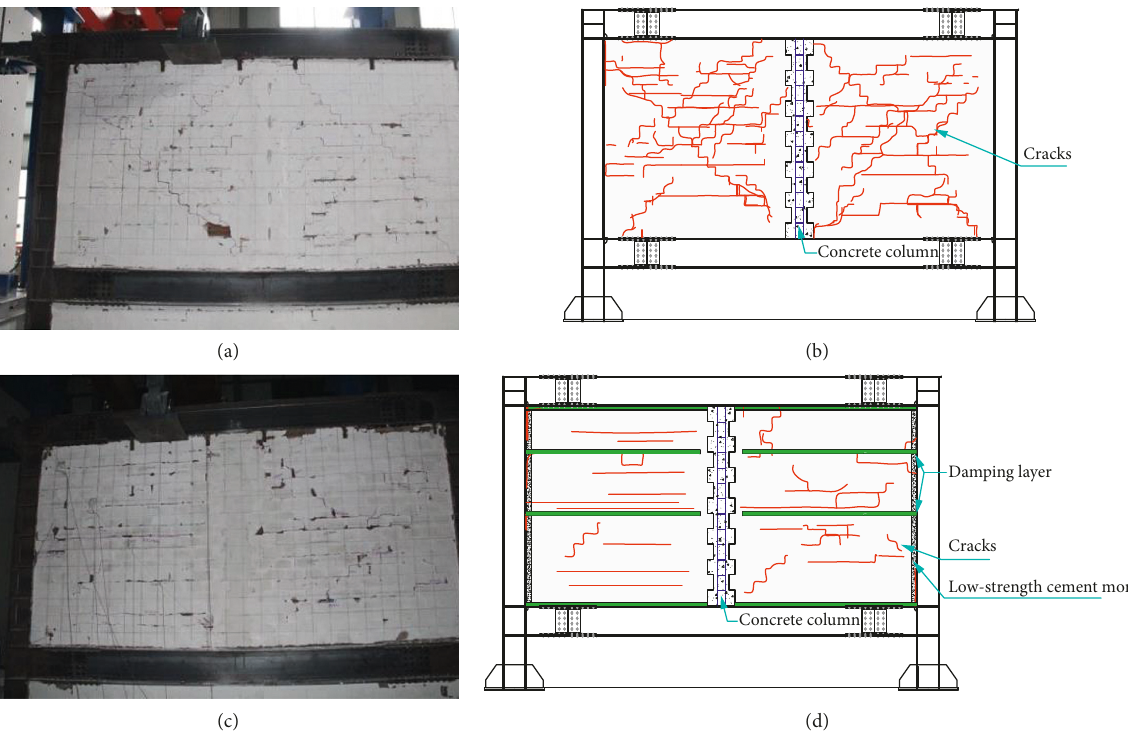
Figure 9: The failure modes of tested samples. (a) The failure mode of TMWF. (b) The crack distribution of TMWF. (c) The failure mode of PDWF. (d) The crack distribution of